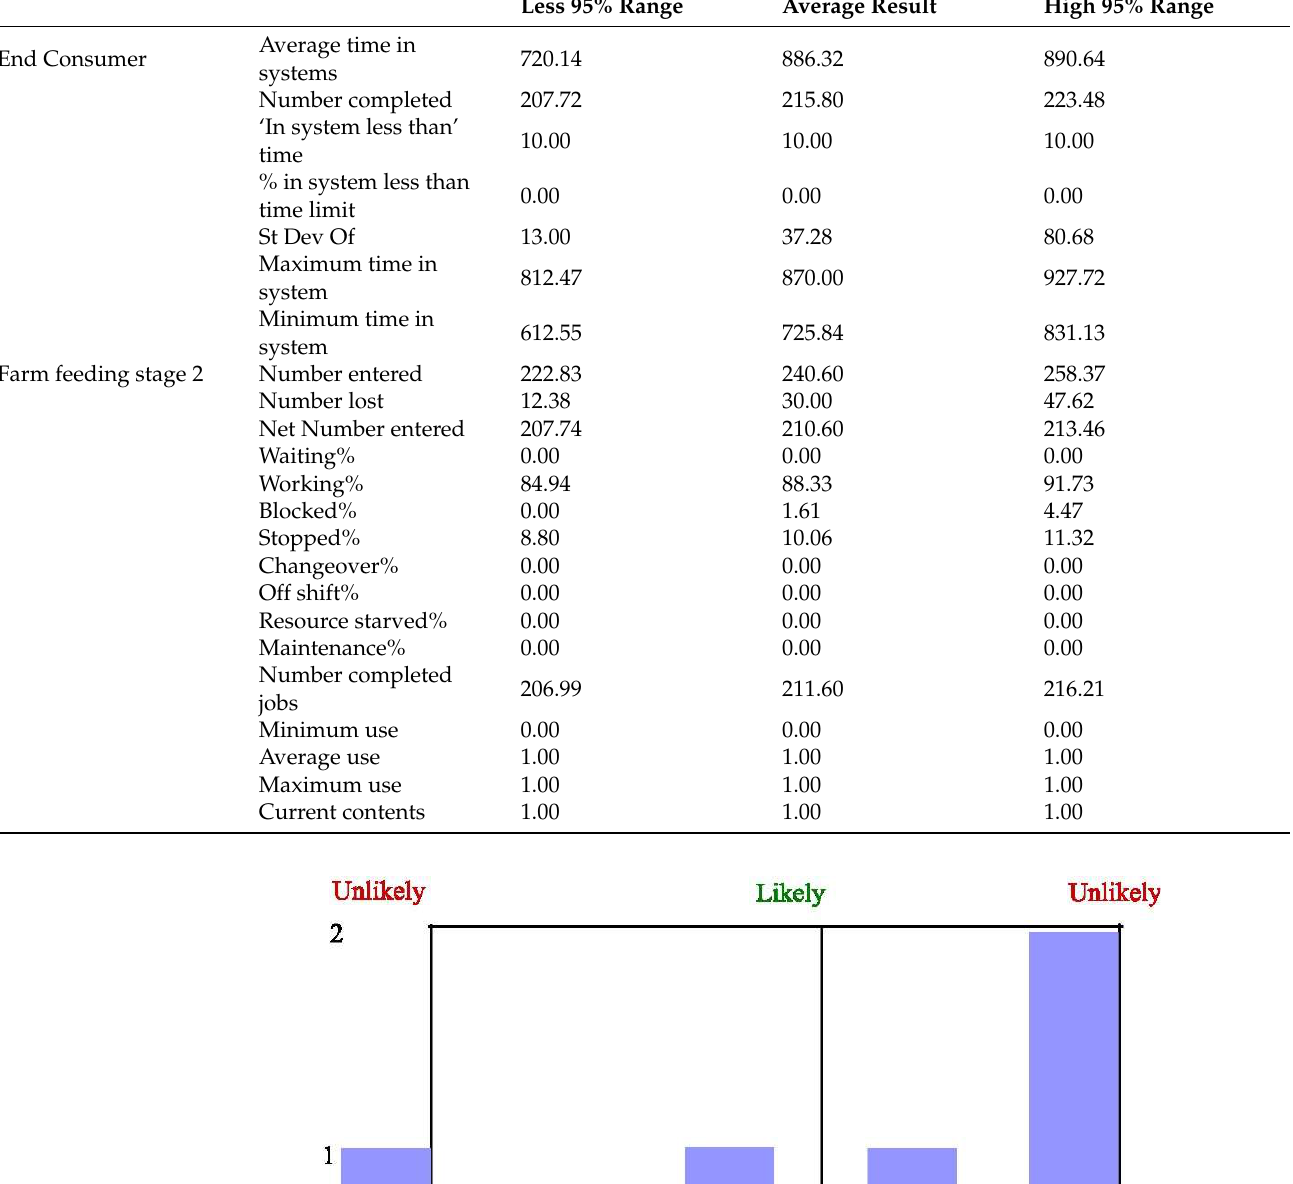
Table 5. KPI values for beef supply chain simulated model.